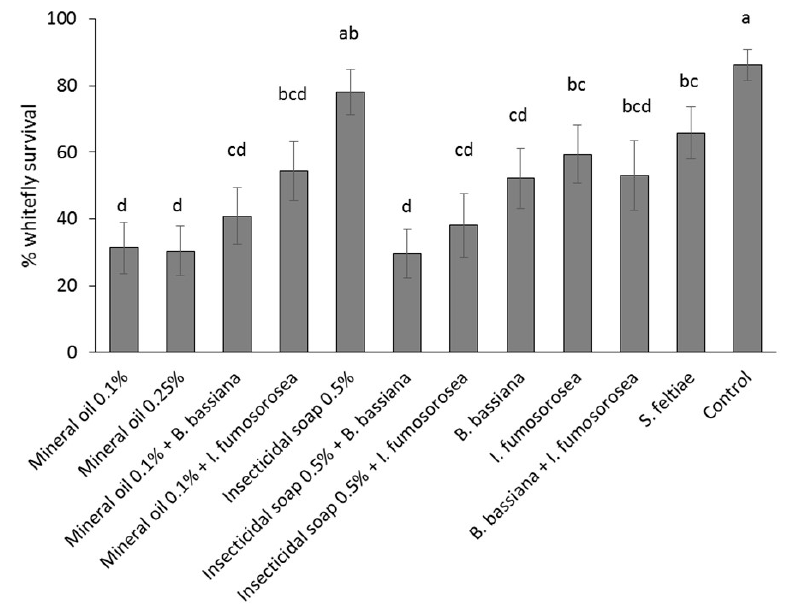
Figure 3. Efficacy (mean percent survival 2 weeks post-treatment ± SE) of reduced risk and biopesticide products against Bemisia tabaci (eggs, first and second instar) on greenhouse poinsettia cuttings. Different letters indicate significant differences in efficacy among products ( α = 0.05).